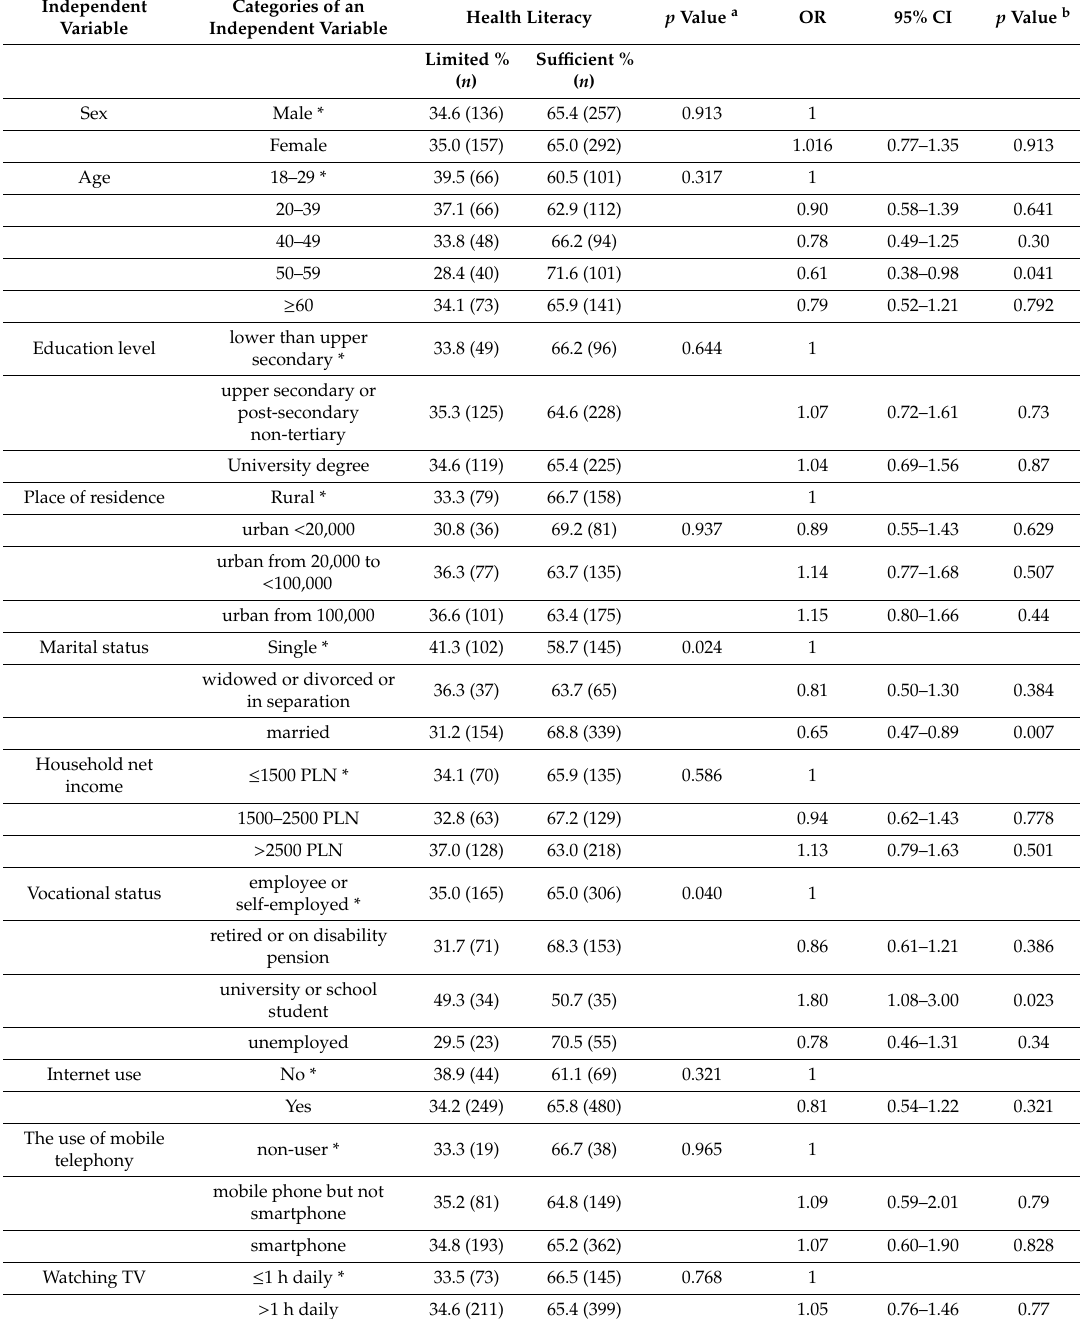
Table 2. The assessment of potential antecedents of limited health literacy (HL) with chi2 test and univariate logistic